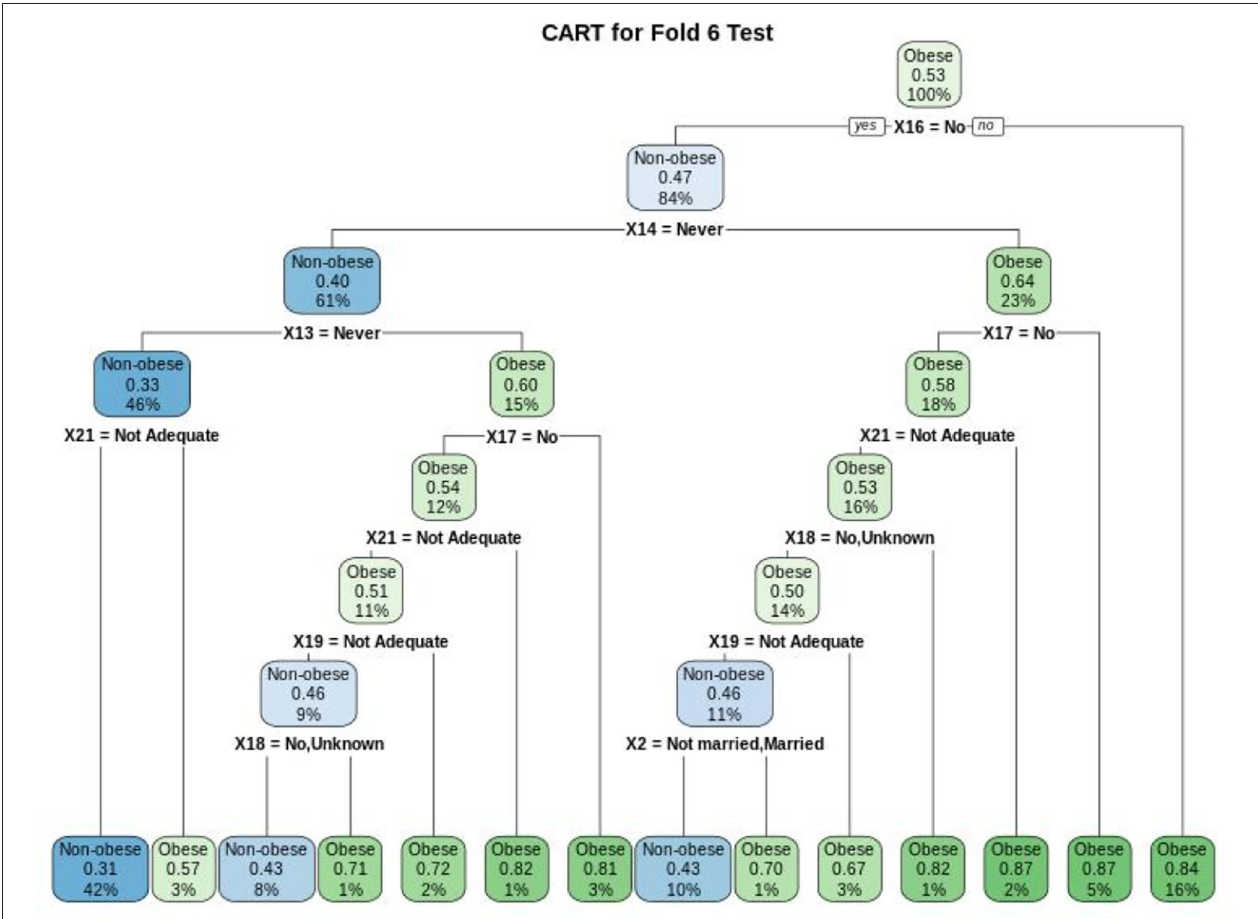
FIGURE 4 | Obesity data classification tree for fold 6 out of the 10-fold CV for CART model based on the variables of alcoholic drinks (X16), energy drinks (X14), soft/carbonated drinks (X13), mental-emotional disorders (X17), Fruit and Vegetables Consumptions (X21), diagnosed hypertension (X18), Physical Activity (X19), and Marital Status